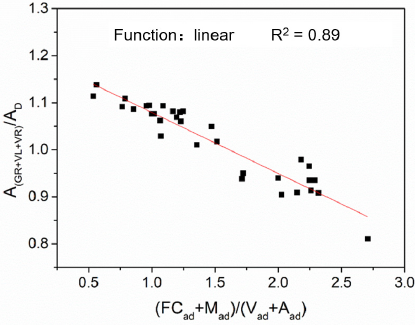
Figure 9. The correlation between the comprehensive coal property parameter (FC ad + M ad )/(V ad + A ad ) of parent coal and A (GR+VL+VR) /A D of its pyrolytic